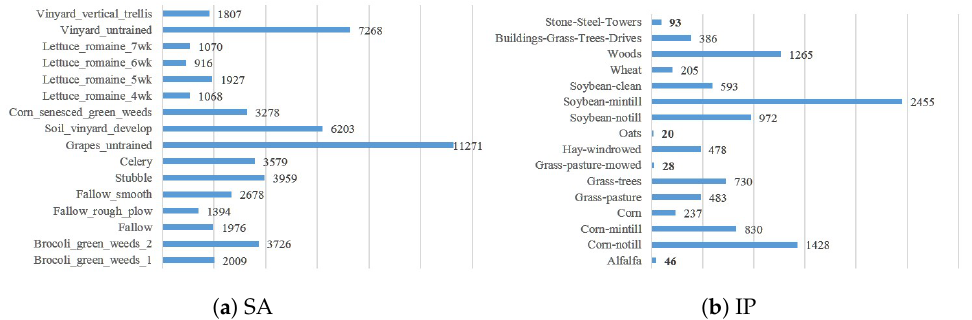
Figure 10. The name of categories and the corresponding number of labeled samples of datasets in Group A.